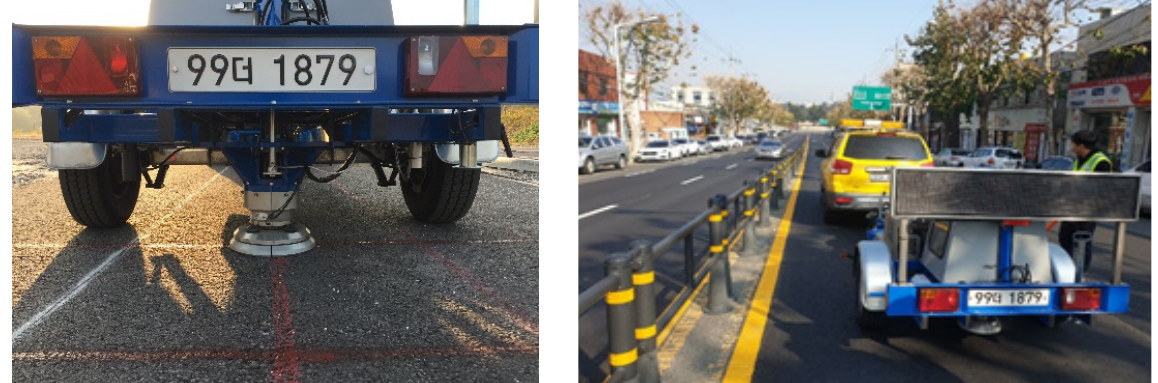
Figure 9. FWD test process.